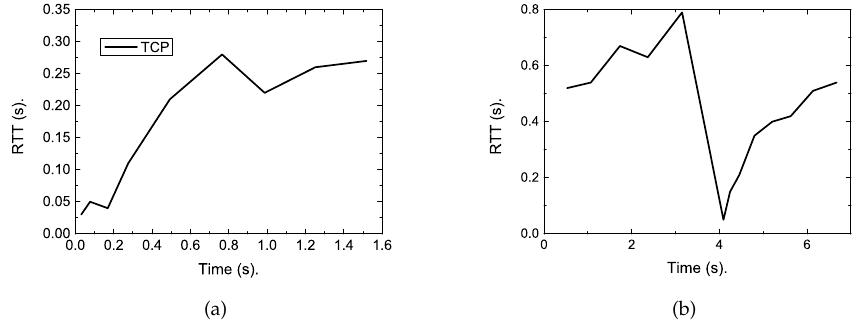
Figure 3. The traced round trip time (RTT) varying with time of the short flow. ( a ) No competing long flow exists, ( b ) The competing long flow